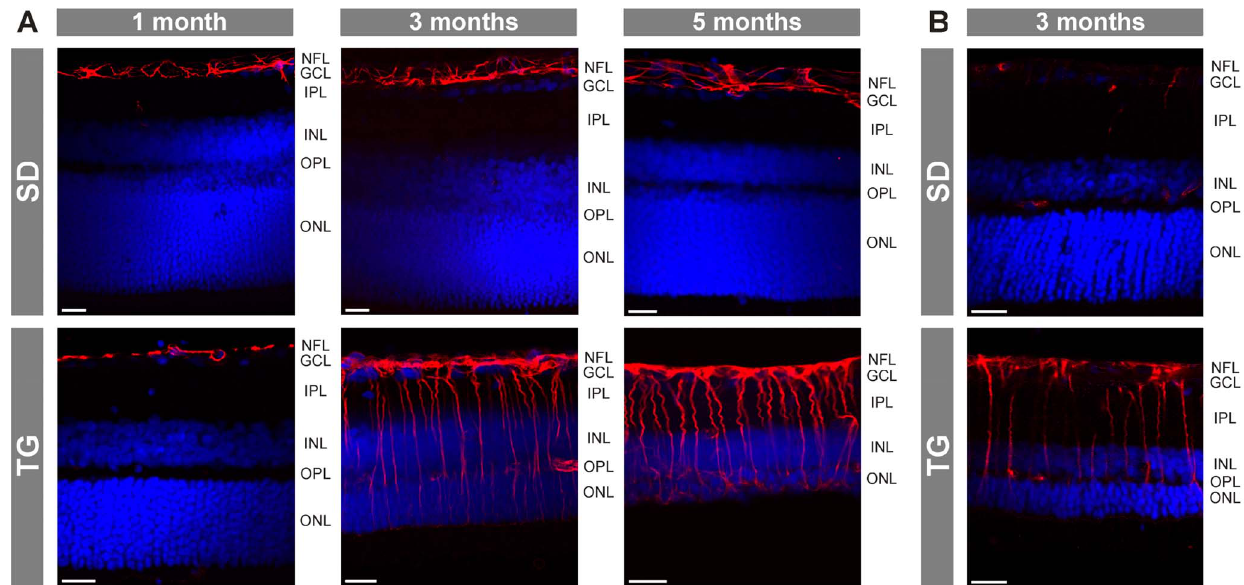
Figure 2. Immunolocalization of GFAP (A) and nestin (B) in retinal slices. The slices were obtained from control (SD; above ) and transgenic (TG) rats ( below ). Cell nuclei were labeled with Hoechst 33258 ( blue ). Note the age-dependent thinning of the outer nuclear layer (ONL) in the tissues of TG rats. GCL, ganglion cell layer; IPL, inner plexiform layer; INL, inner nuclear layer; NFL, nerve fiber layer; OPL, outer plexiform layer. Bars, 20 m m.